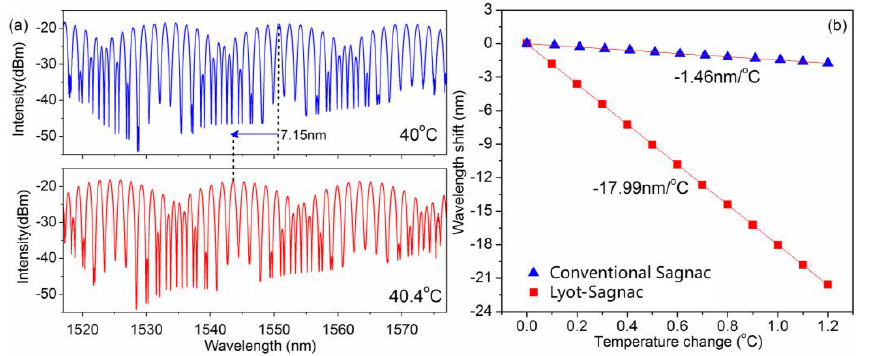
Figure 3. ( a ) Spectra of Lyot-Sagnac interferometer at 40.0 °C and 40.4 °C; ( b ) Temperature responses of the Lyot-Sagnac interferometer.